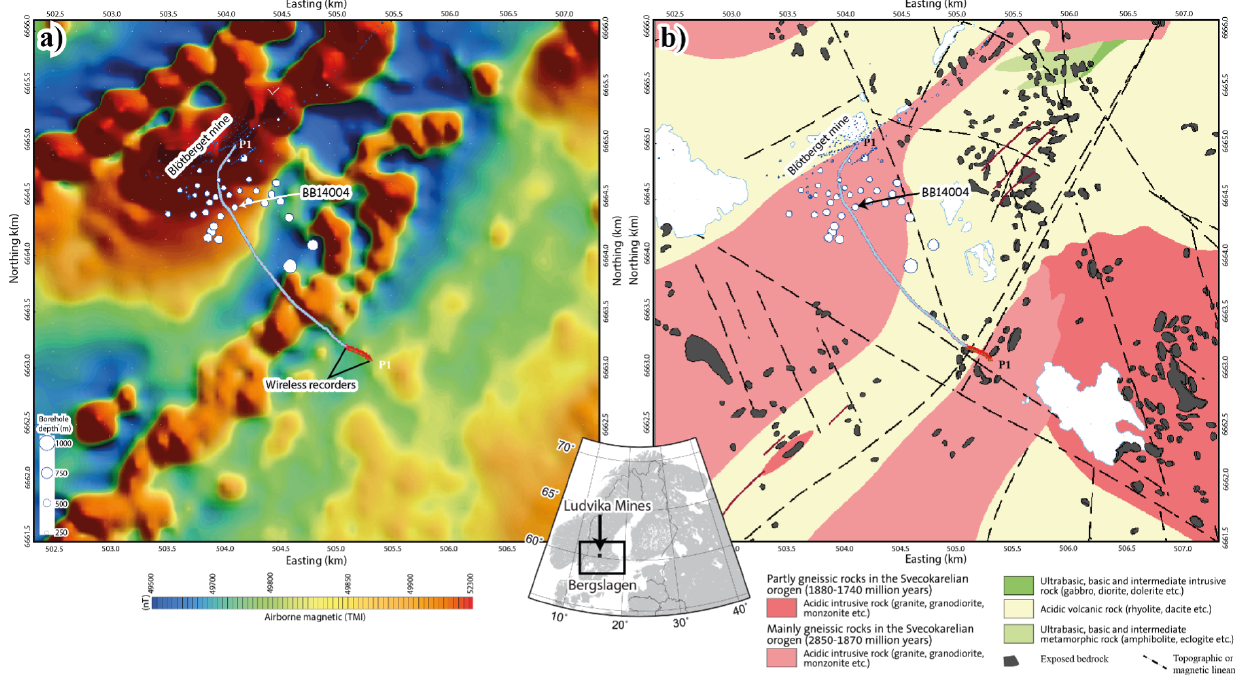
Figure 1. (a) Total-field aeromagnetic and (b) geological maps of Blötberget within the Ludvika mines of the Bergslagen mineral district in central Sweden. A 2D seismic survey (blue line) and borehole BB14004 are used in this study. Magnetic data were provided by the Geological Survey of Sweden.